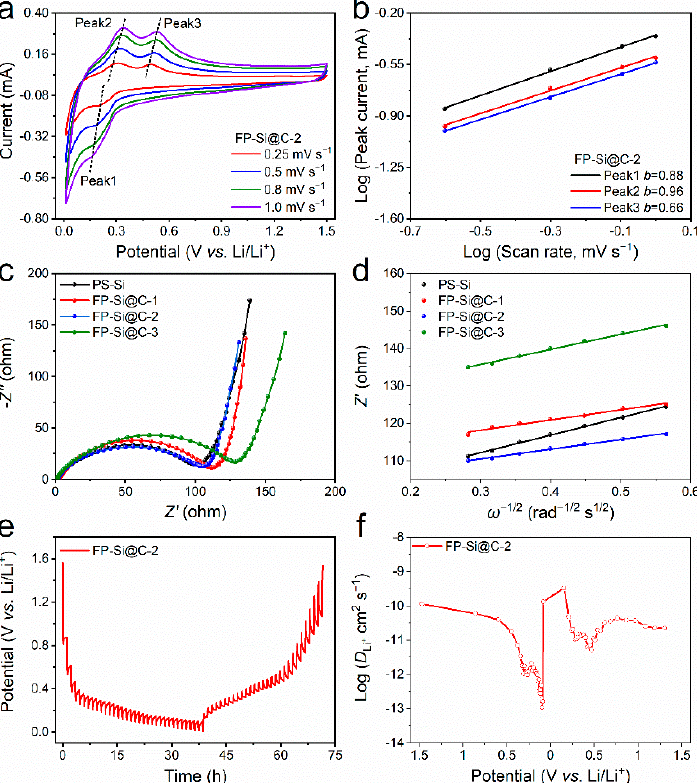
Figure 4. Kinetic analysis of Si-based anodes. ( a ) The CV curves of FP-Si@C-2 at different scan rates; ( b ) The log( i ) ‒ log( v ) plots of FP-Si@C-2; ( c ) electrochemical impedance spectra of P-SiCW, FP-Si@C-1, FP-Si@C-2, and FP-Si@C-3; ( d ) fitting Z ′ and ω − 1/2 of P-SiCW, FP-Si@C-1, FP-Si@C-2, and FP-Si@C-3; ( e ) GITT profiles of FP-Si@C-2; ( f ) Li+ diffusion coefficients of FP-Si@C-2.